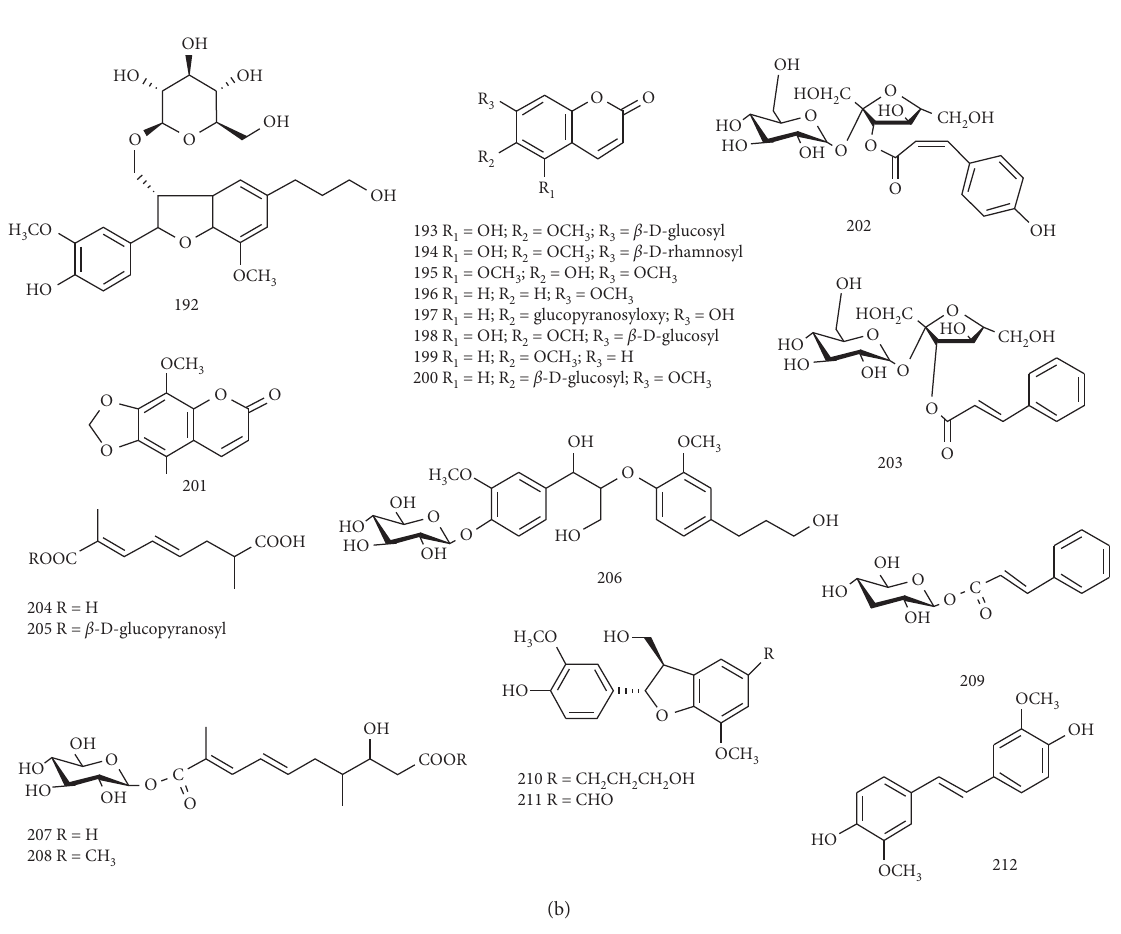
Figure 3: Chemical structures of other compounds from Prunus